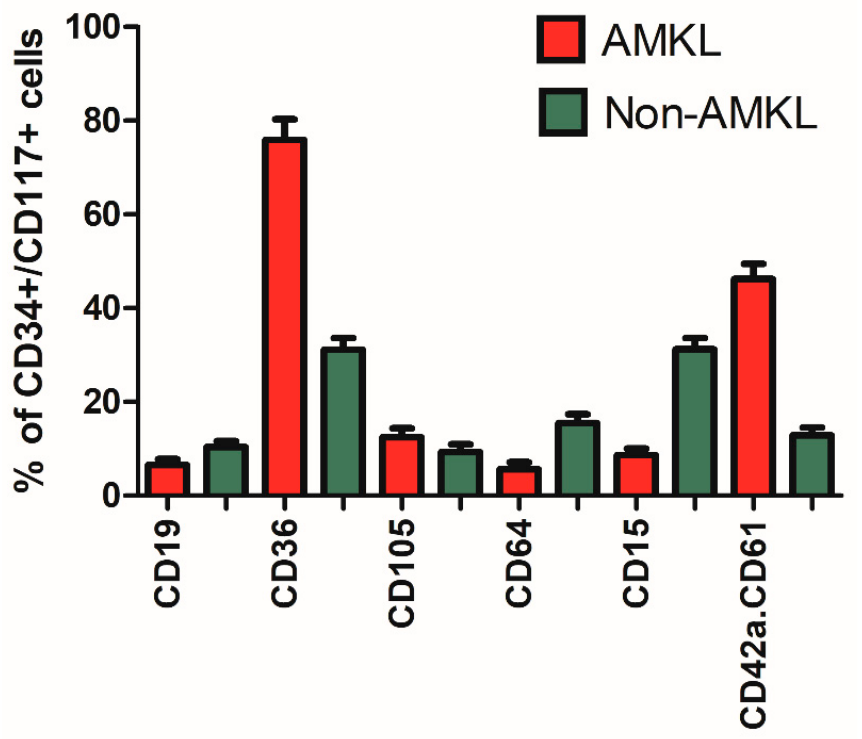
Figure 2. Differentiation of CD34+/CD117+ AML cells in AMKL (red bars) and non-AMKL patients (green bars). Percentage of positive cells, defined as cells with an MFI > 1000 (mean ± SEM). Differ- entiation towards B-cell (CD19+), megakaryocytic/erythroid (CD36+/CD64 − ), erythroid (CD105+), monocytic (CD64+), granulocytic (CD15+) and megakaryocytic (CD42a.CD61+) lineage is shown. Given the observed heterogeneity in expression of CD34 and CD117 in AMKL patients, we further evaluated whether there were immunophenotypic differences between various maturation stages within the AMKL patients. Thus, for all AMKL patients, AML cells were divided into CD34+/CD117+, CD34 ‐ /CD117+, CD34+/CD117 ‐ and CD34 ‐ /CD117 ‐ subsets (based on the backbone markers present in all tubes). As shown in Figure 3 and Supplementary Figure S6, several markers, including maturation markers, such as CD11b, CD14 and CD64, were more strongly expressed in the CD34 ‐ /CD117 ‐ subset, which is in line with their presumed higher degree of differentiation. In contrast, CD13, CD33, CD7 and CD38 expression was higher in the CD34+/CD117+ subset. The megakar ‐ yocytic markers (CD41, CD42b, CD42a.CD61 and CD36) showed rather similar expression between the four maturation subsets, although their expression was generally highest in the CD117 ‐ negative subsets. In turn, CD123 was most strongly expressed in the CD34+/CD117 ‐ subset (Supplementary Figure S6).